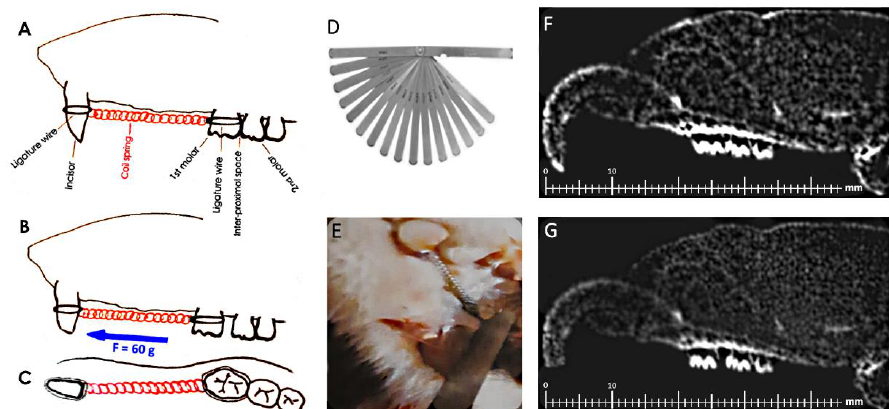
Figure 1. Applied forces through OTM appliances resulted in an inter-proximal space. ( A ) Before applying the force, the inter-proximal space between the first and second molars was zero. ( B ) A distance was created between the first and second molars due to the applied force. The first molar was pulled towards the incisor teeth by an activated coil spring providing 60 g of force. ( C ) OTM appliance setting from an occlusal view. ( D ) A Feeler Gauge used for manual measurement of a gap ( E ) Use of a Feeler Gauge for the measurement of a distance between the molar teeth on a rat jaw. ( F , G ) Radiographs showing rat maxillary jaws without and with the first molar moved,